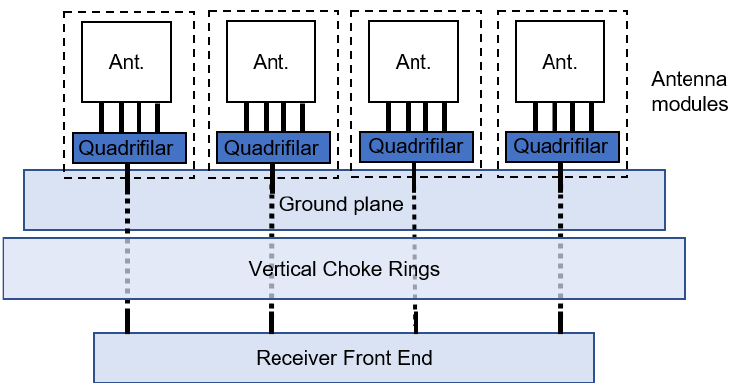
Figure 1. Concept of the miniaturized antenna array for UAV applications consisting of individual antenna modules mounted on a ground plane and connected to the receiver